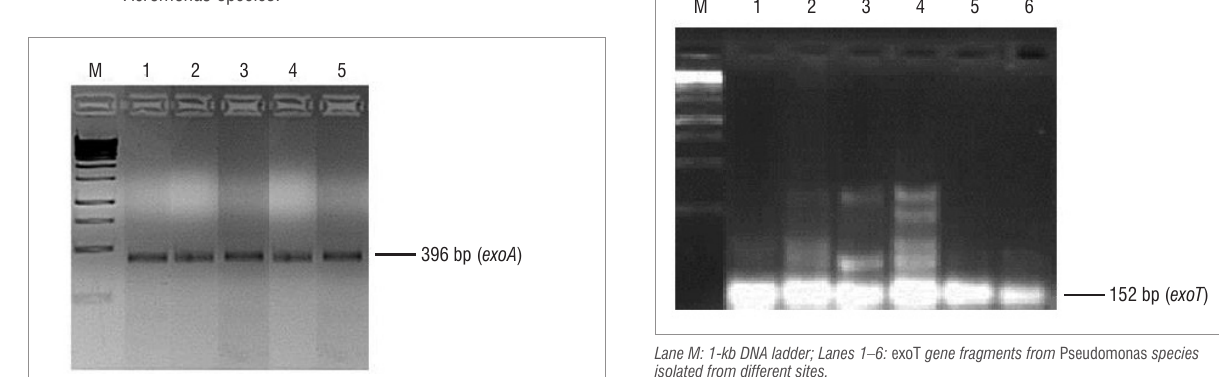
Figure 6: Image of an agarose (1% w/v) gel depicting the hylH gene from Aeromonas species.